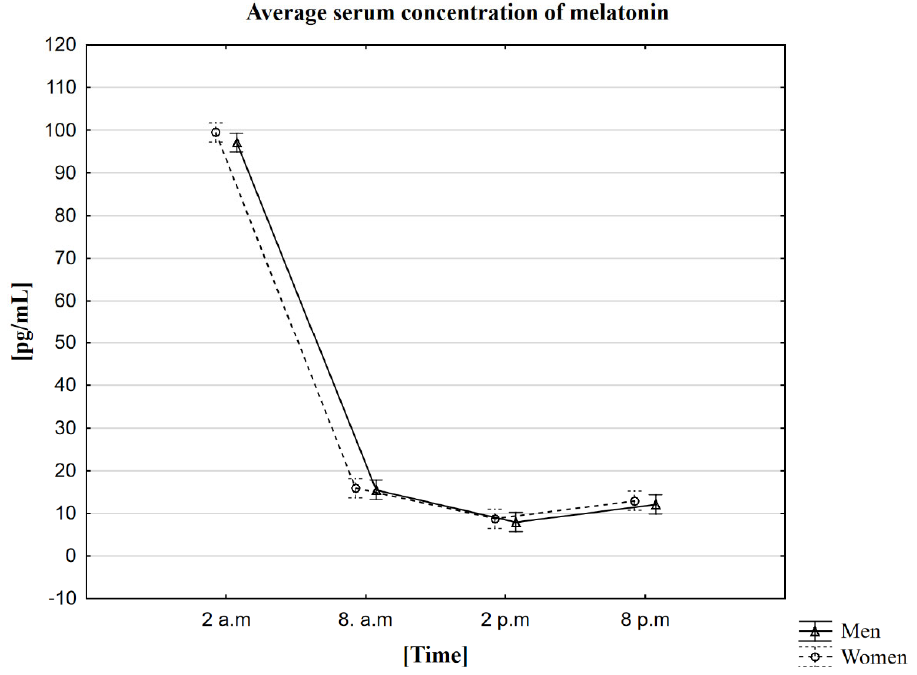
Table 2. Parameters describing melatonin concentration in women and men, including the time of blood collection [pg/mL].